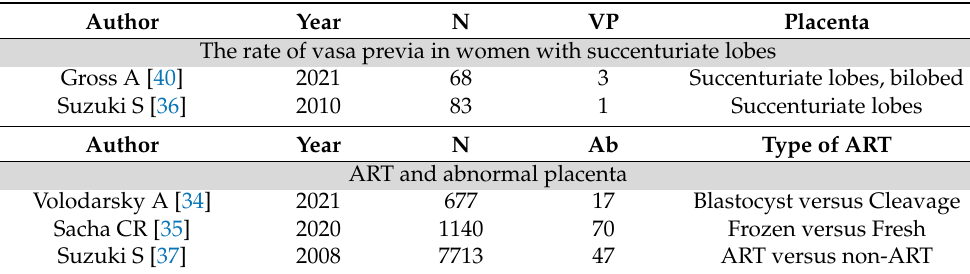
Table 3. The examination for secondary outcomes and sensitivity